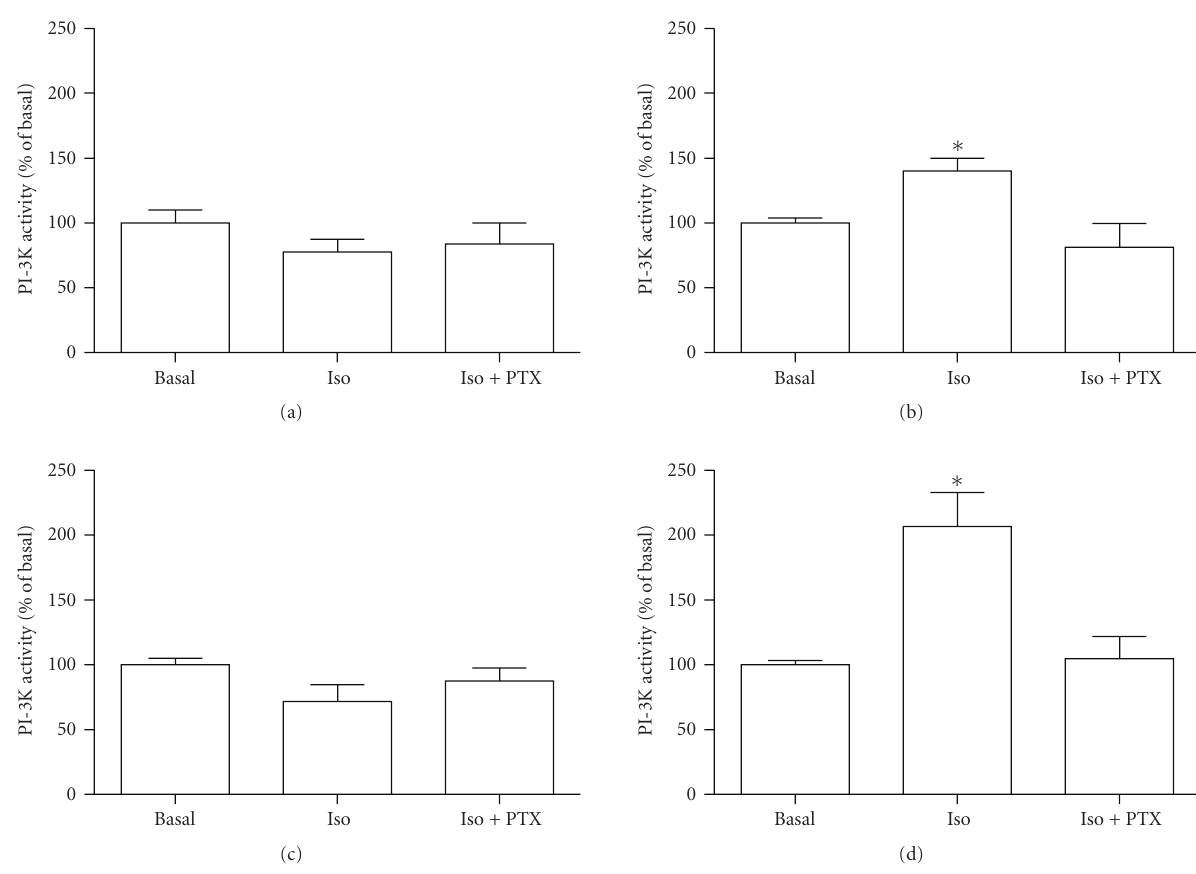
Figure 7: Pertussis toxin e ff ects on β -AR-mediated PI-3K activation . Twenty-six hours after transfection, cells were incubated with 0.1 μ g/mL pertussis toxin for 18 hours. Cells were stimulated for 5 minutes with 1 μ M isoproterenol prior to processing for TLC as described in Figure 1 and Section 2. PI-3K activity was determined by the level of [ 32 P ]-PI produced by the stimulation of β 1 -AR (a), β 2 -AR (b), β 2 × β 1 -AR (c), and β 1 × β 2 -AR expressing cells. ( n = 3-4; ∗ P < . 05 versus basal and PTX-Iso